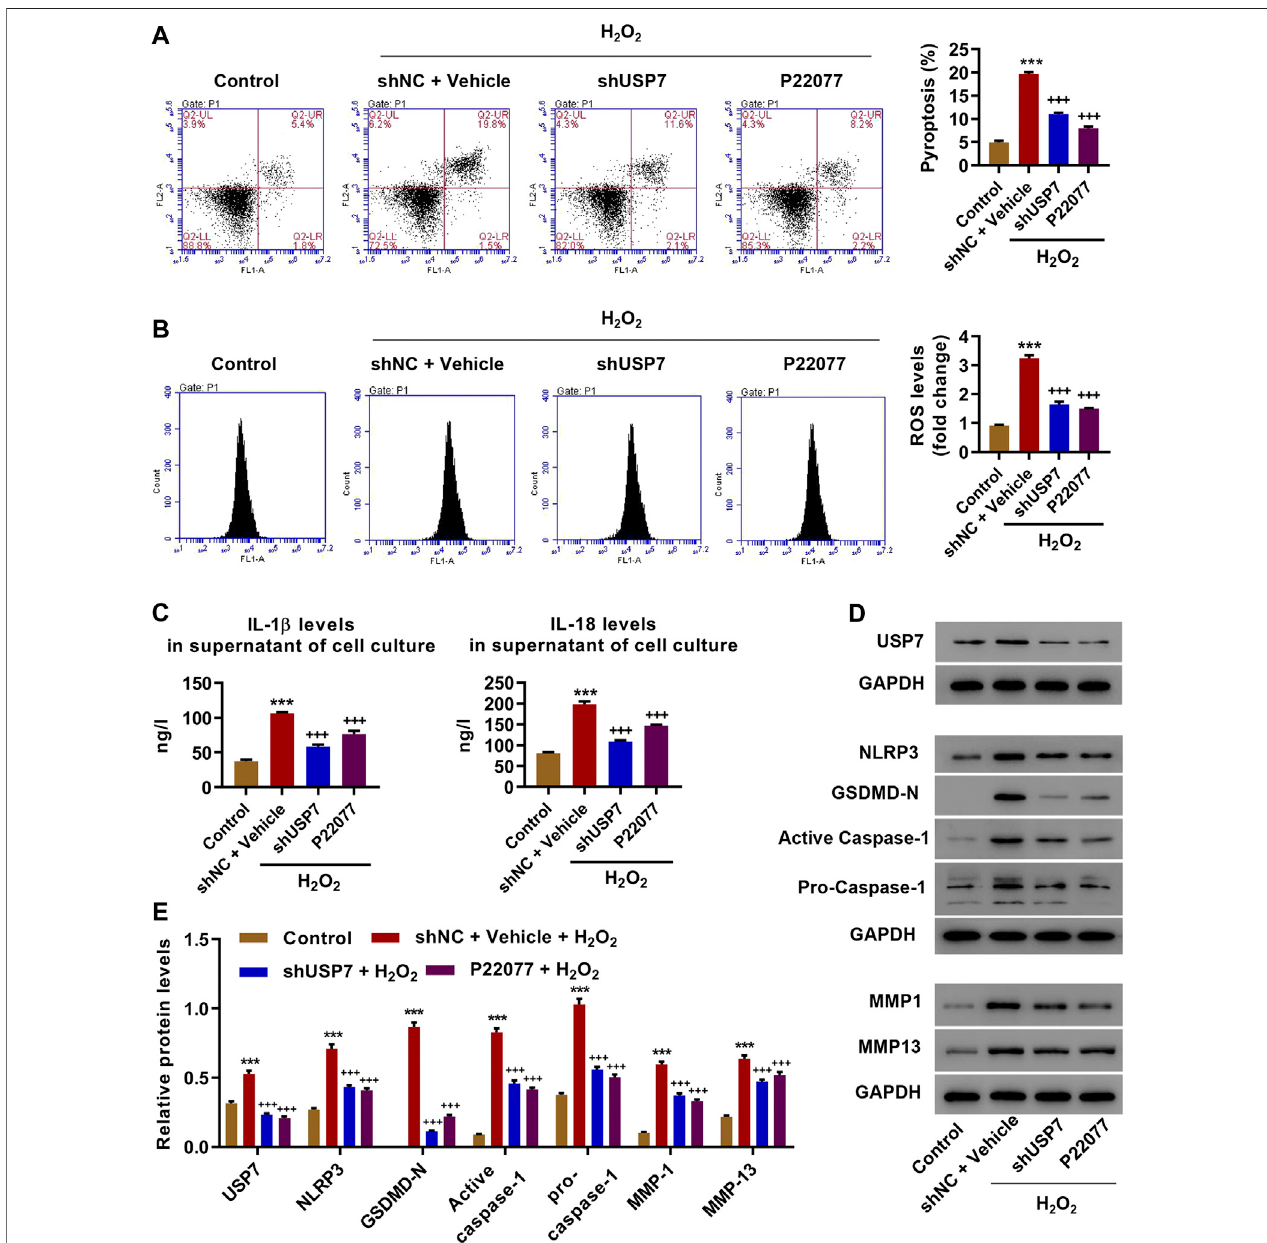
FIGURE2| USP7KDinhibitedH 2 O 2 -inducedinjuryinratchondrocytes.Ratchondrocytesweretreatedwith100 μ MH 2 O 2 andtransducedwithUSP7shRNAvectorortreated withUSP7inhibitor5 μ MP22077,and (A) pyroptosis (B) ROSproduction, (C) IL-1 β andIL-18levels,and (DandE) expressionlevelsofUSP7,NLRP3,GSDMD-N,activecaspase-1, pro-caspase-1, MMP1, and MMP13 was measured by fl ow cytometry, ELISA, and Western blot, respectively. *** p < 0.001 vs control; ++ + p < 0.001 vs H 2 O 2 + shNC + vehicle.